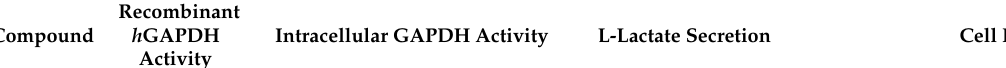
Table 3. Summary of the overall results.